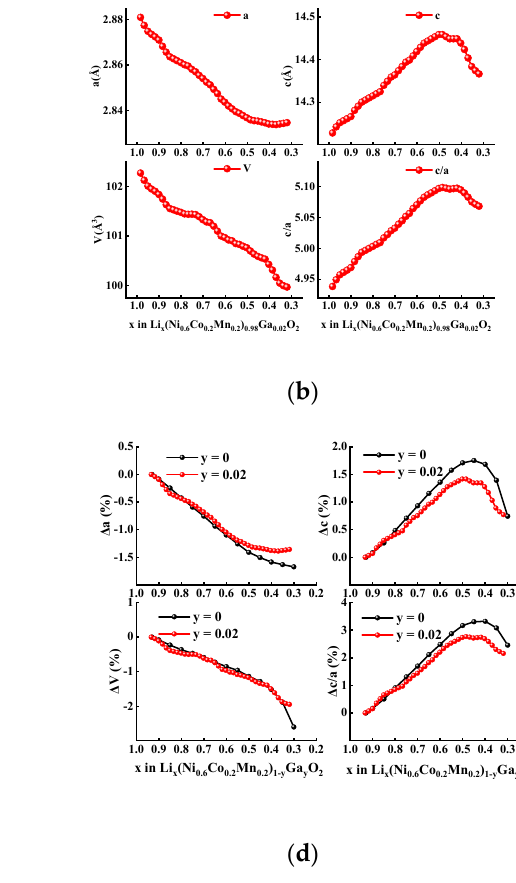
Figure 10. In situ XRD analysis for Li[Ni 0.6 Co 0.2 Mn 0.2 ] 0.98 Ga 0.02 O 2 electrode during charging process from 2.8 V to 4.3 V: ( a ) (003) diffraction peaks; ( b ) contour plots; ( c ) changes in lattice parameters; ( d ) relative change of lattice parameters (the data for sample with y = 0 from reference [5]).